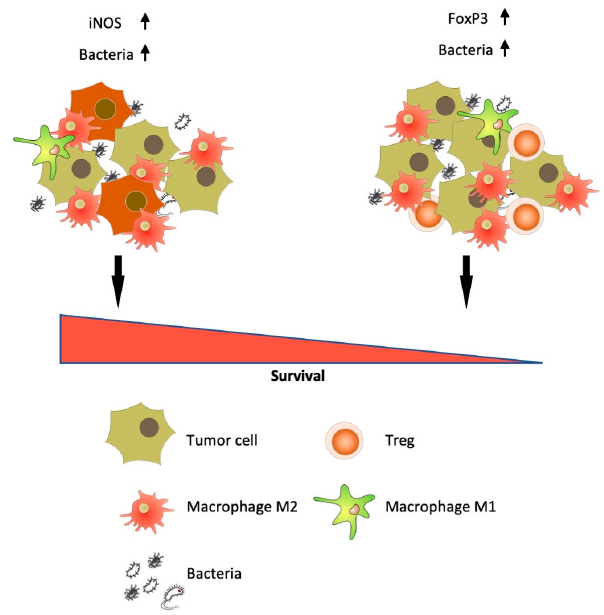
Figure 10. Bacterial load as an additional prognostic marker for NSCLC.